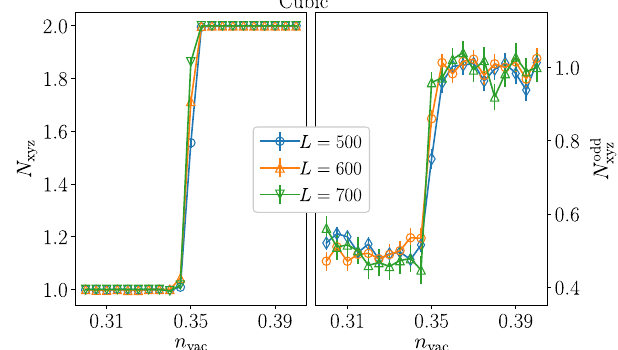
FIG. 15. N , the number of R -type regions that wrap around xyz cubic lattice in three independent directions, jumps at a sharply ¼ 0 . 35 ð 1 Þ from 2 to 1 in the thermody- defined threshold n low vac namic limit. Correspondingly, the number N odd of such odd R - xyz type regions jumps from a mean value of 1 to a mean value close to 0.5. See Sec. VII C for details.